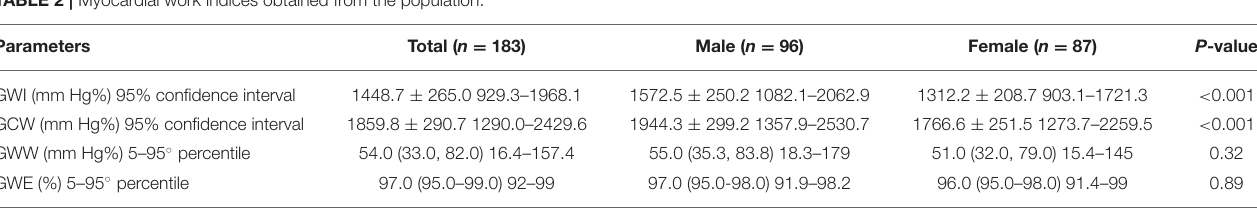
TABLE 2 | Myocardial work indices obtained from the population.